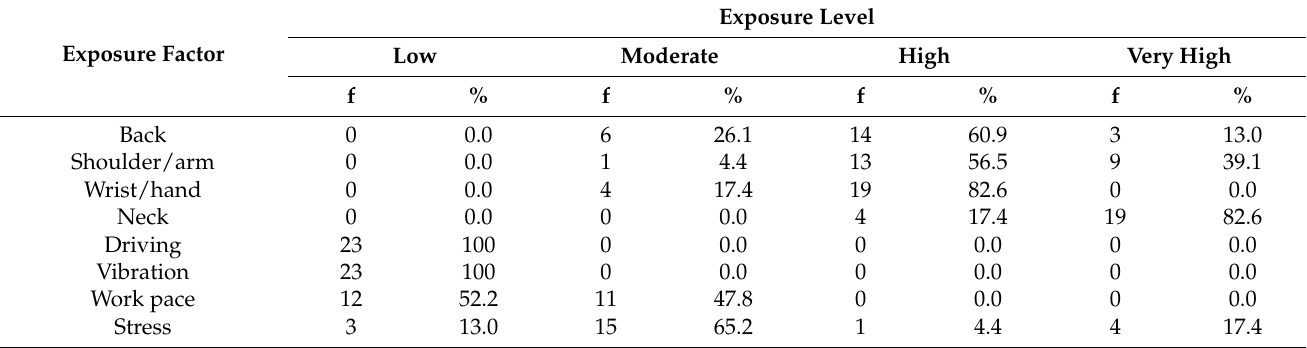
Table 10. Frequency (f) and percentage (%) of cutters for each factor according to the level of exposure based on the scores proposed by the QEC method ( n =